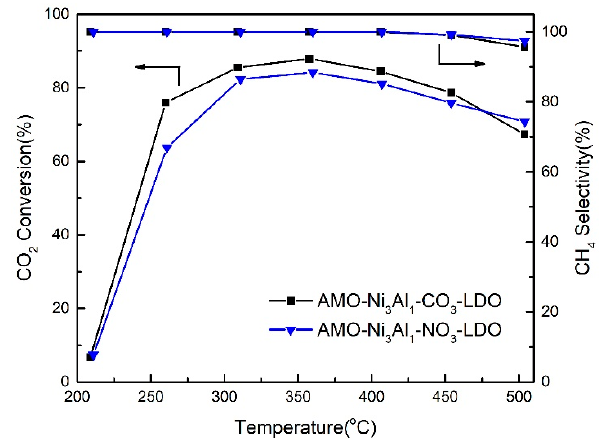
Figure 4. CO 2 conversion and CH 4 selectivity vs T profiles of AMO-Ni 3 Al 1 -CO 3 -LDO and AMO- Ni 3 Al 1 -NO 3 -LDO catalysts for the CO 2 methanation reaction.